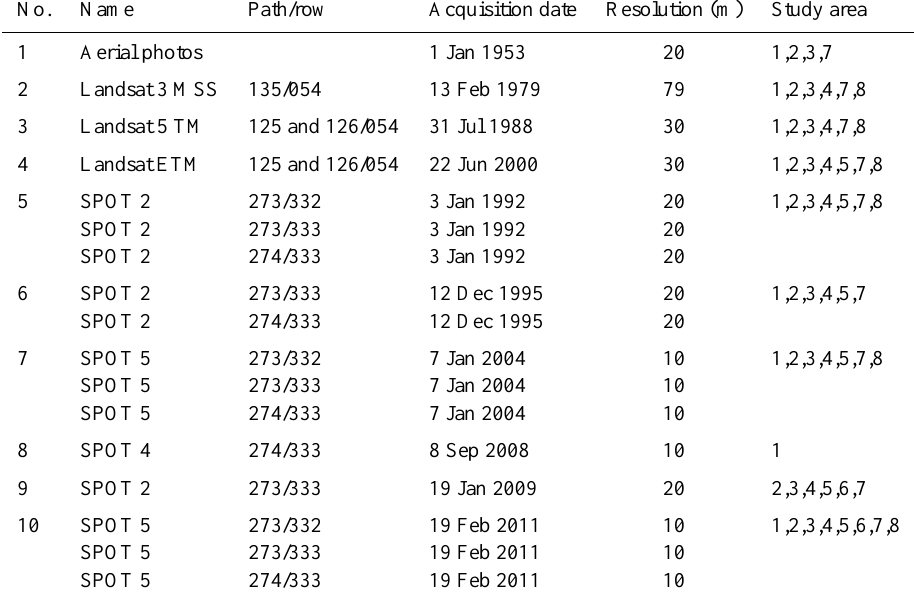
Table 3. Specifications of image data.